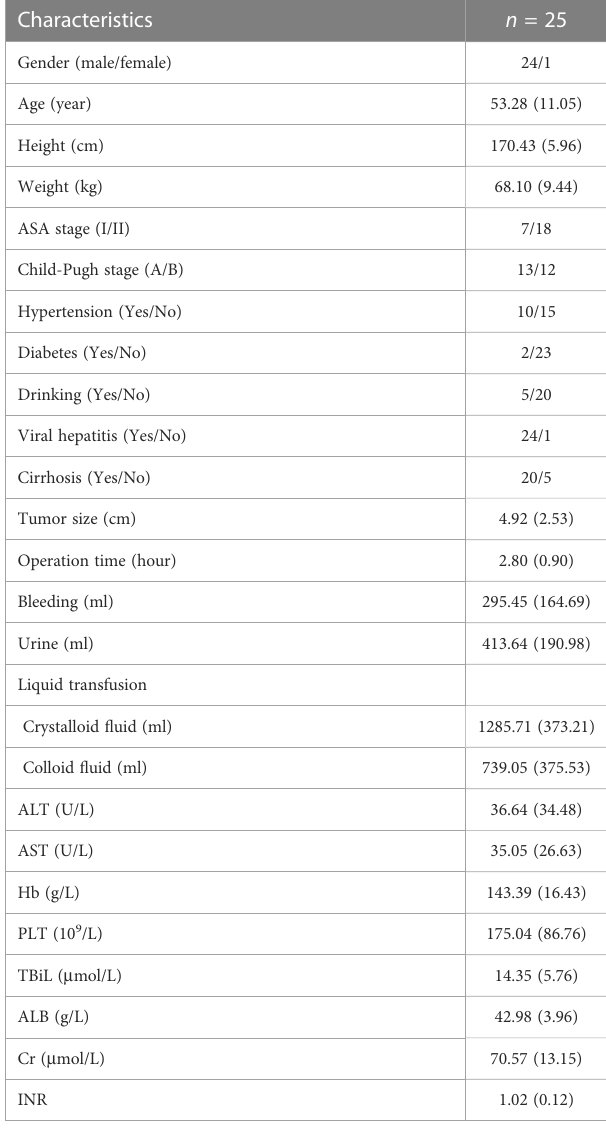
TABLE 1 Clinical characteristics of patients with HCC.